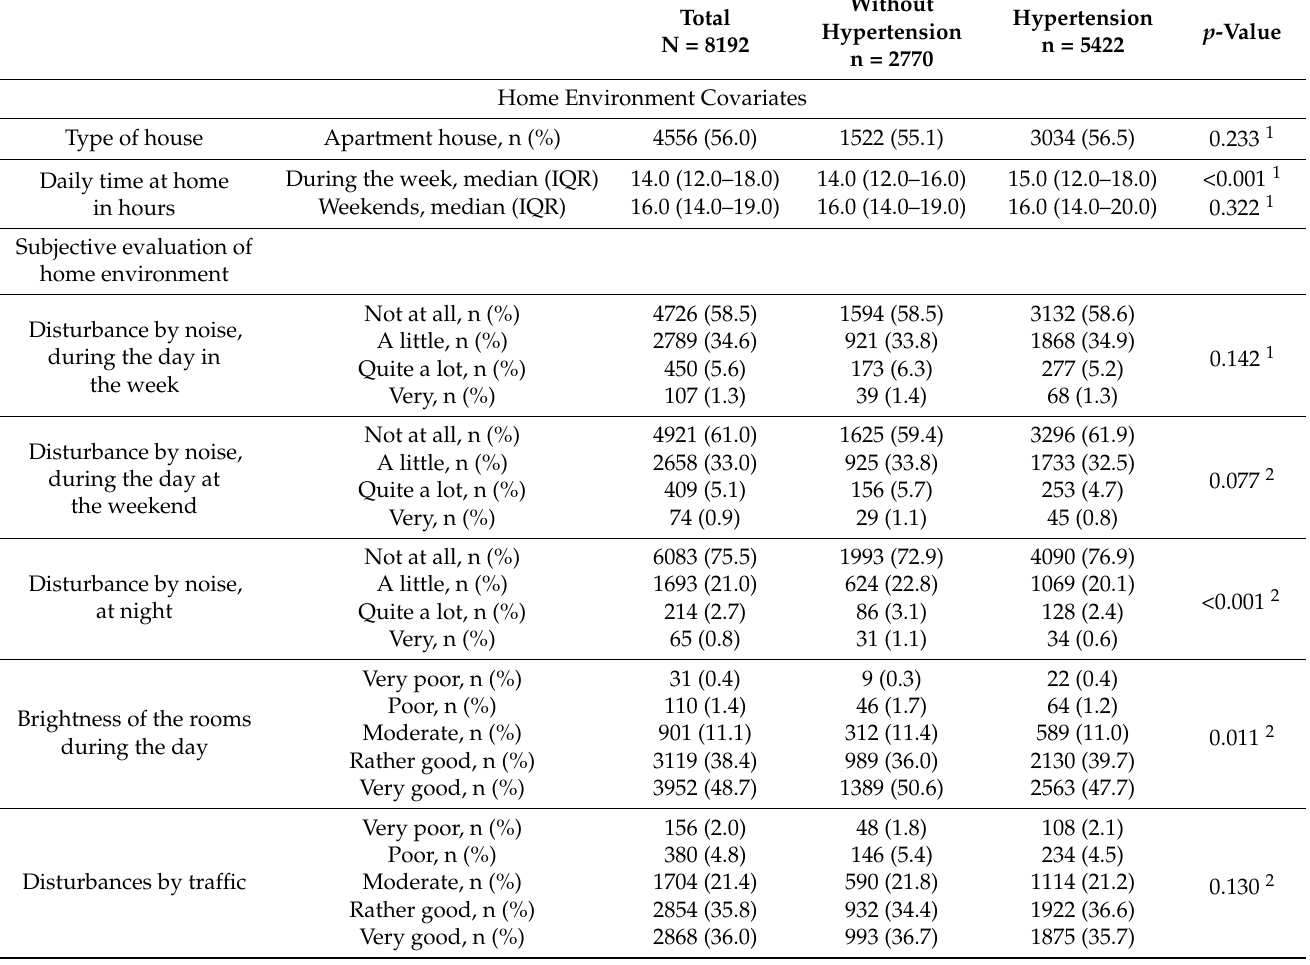
Table 3. Home environment covariates and subjective evaluation of home